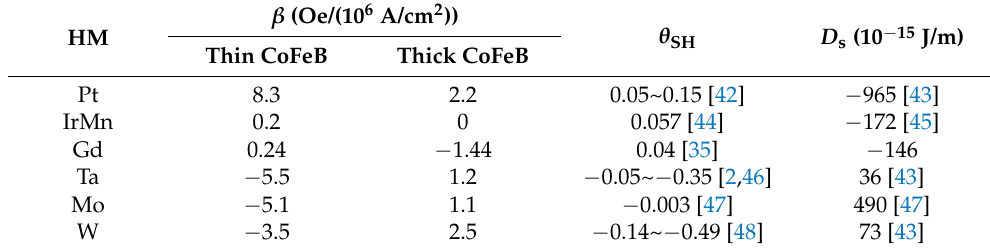
Figure 4. The summarized β as a function of wedged CoFeB thickness in X/CoFeB systems, where X are Pt, IrMn, Gd, Ta, Mo, and W. The inset shows the enlarged IrMn/CoFeB case. Table 1. Room temperature β , θ SH , and D s in this